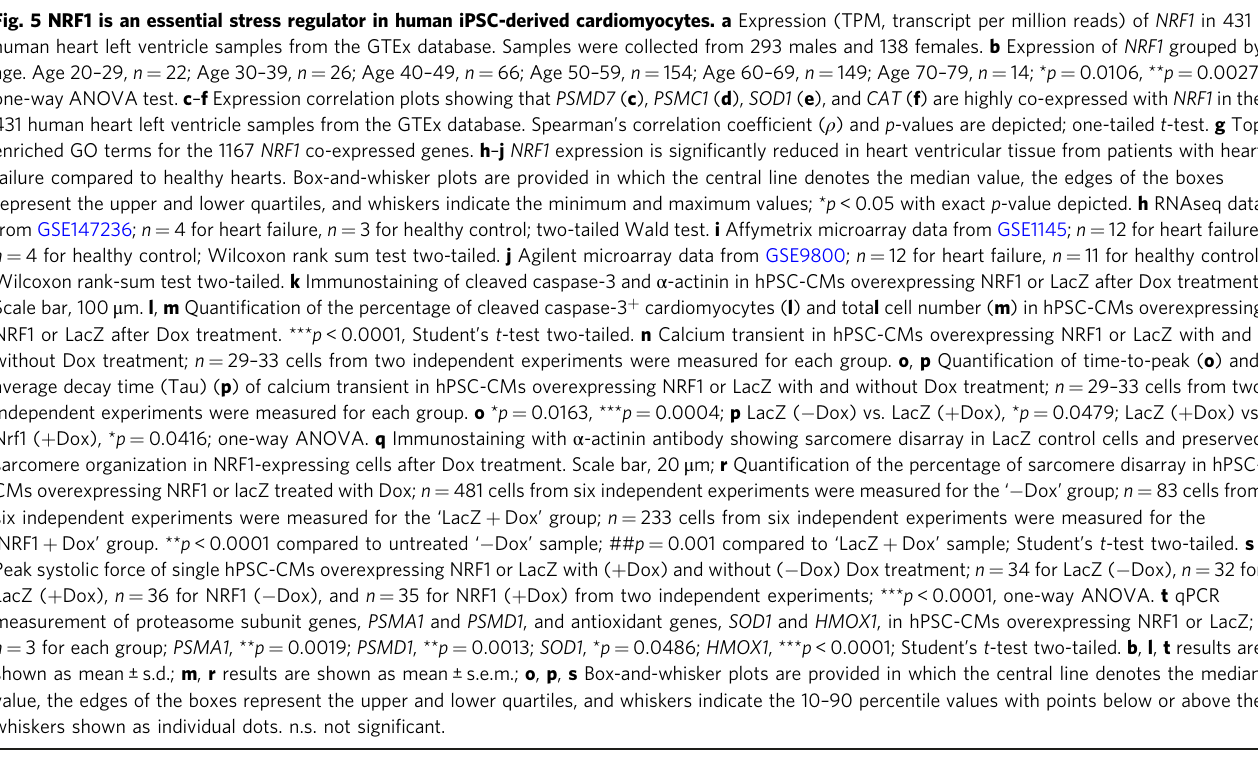
Fig. 5 NRF1 is an essential stress regulator in human iPSC-derived cardiomyocytes. a Expression (TPM, transcript per million reads) of NRF1 in 431 human heart left ventricle samples from the GTEx database. Samples were collected from 293 males and 138 females. b Expression of NRF1 grouped by age. Age 20 – 29, n = 22; Age 30 – 39, n = 26; Age 40 – 49, n = 66; Age 50 – 59, n = 154; Age 60 – 69, n = 149; Age 70 – 79, n = 14; * p = 0.0106, ** p = 0.0027, one-way ANOVA test. c – f Expression correlation plots showing that PSMD7 ( c ), PSMC1 ( d ), SOD1 ( e ), and CAT ( f ) are highly co-expressed with NRF1 in the 431 human heart left ventricle samples from the GTEx database. Spearman ’ s correlation coef fi cient ( ρ ) and p -values are depicted; one-tailed t -test. g Top enriched GO terms for the 1167 NRF1 co-expressed genes. h – j NRF1 expression is signi fi cantly reduced in heart ventricular tissue from patients with heart failure compared to healthy hearts. Box-and-whisker plots are provided in which the central line denotes the median value, the edges of the boxes represent the upper and lower quartiles, and whiskers indicate the minimum and maximum values; * p < 0.05 with exact p -value depicted. h RNAseq data from GSE147236; n = 4 for heart failure, n = 3 for healthy control; two-tailed Wald test. i Affymetrix microarray data from GSE1145; n = 12 for heart failure, n = 4 for healthy control; Wilcoxon rank sum test two-tailed. j Agilent microarray data from GSE9800; n = 12 for heart failure, n = 11 for healthy control; Wilcoxon rank-sum test two-tailed. k Immunostaining of cleaved caspase-3 and α -actinin in hPSC-CMs overexpressing NRF1 or LacZ after Dox treatment. Scale bar, 100 μ m. l , m Quanti fi cation of the percentage of cleaved caspase-3 + cardiomyocytes ( l ) and tota l cell number ( m ) in hPSC-CMs overexpressing NRF1 or LacZ after Dox treatment. *** p < 0.0001, Student ’ s t -test two-tailed. n Calcium transient in hPSC-CMs overexpressing NRF1 or LacZ with and without Dox treatment; n = 29 – 33 cells from two independent experiments were measured for each group. o , p Quanti fi cation of time-to-peak ( o ) and average decay time (Tau) ( p ) of calcium transient in hPSC-CMs overexpressing NRF1 or LacZ with and without Dox treatment; n = 29 – 33 cells from two independent experiments were measured for each group. o * p = 0.0163, *** p = 0.0004; p LacZ ( − Dox) vs. LacZ ( + Dox), * p = 0.0479; LacZ ( + Dox) vs. Nrf1 ( + Dox), * p = 0.0416; one-way ANOVA. q Immunostaining with α -actinin antibody showing sarcomere disarray in LacZ control cells and preserved sarcomere organization in NRF1-expressing cells after Dox treatment. Scale bar, 20 μ m; r Quanti fi cation of the percentage of sarcomere disarray in hPSC- CMs overexpressing NRF1 or lacZ treated with Dox; n = 481 cells from six independent experiments were measured for the ‘ − Dox ’ group; n = 83 cells from six independent experiments were measured for the ‘ LacZ + Dox ’ group; n = 233 cells from six independent experiments were measured for the ‘ NRF1 + Dox ’ group. ** p < 0.0001 compared to untreated ‘ − Dox ’ sample; ## p = 0.001 compared to ‘ LacZ + Dox ’ sample; Student ’ s t -test two-tailed. s Peak systolic force of single hPSC-CMs overexpressing NRF1 or LacZ with ( + Dox) and without ( − Dox) Dox treatment; n = 34 for LacZ ( − Dox), n = 32 for LacZ ( + Dox), n = 36 for NRF1 ( − Dox), and n = 35 for NRF1 ( + Dox) from two independent experiments; *** p < 0.0001, one-way ANOVA. t qPCR measurement of proteasome subunit genes, PSMA1 and PSMD1 , and antioxidant genes, SOD1 and HMOX1 , in hPSC-CMs overexpressing NRF1 or LacZ; n = 3 for each group; PSMA1 , ** p = 0.0019; PSMD1 , ** p = 0.0013; SOD1 , * p = 0.0486; HMOX1 , *** p < 0.0001; Student ’ s t -test two-tailed. b , l , t results are shown as mean ± s.d.; m , r results are shown as mean ± s.e.m.; o , p , s Box-and-whisker plots are provided in which the central line denotes the median value, the edges of the boxes represent the upper and lower quartiles, and whiskers indicate the 10 – 90 percentile values with points below or above the whiskers shown as individual dots. n.s. not signi fi